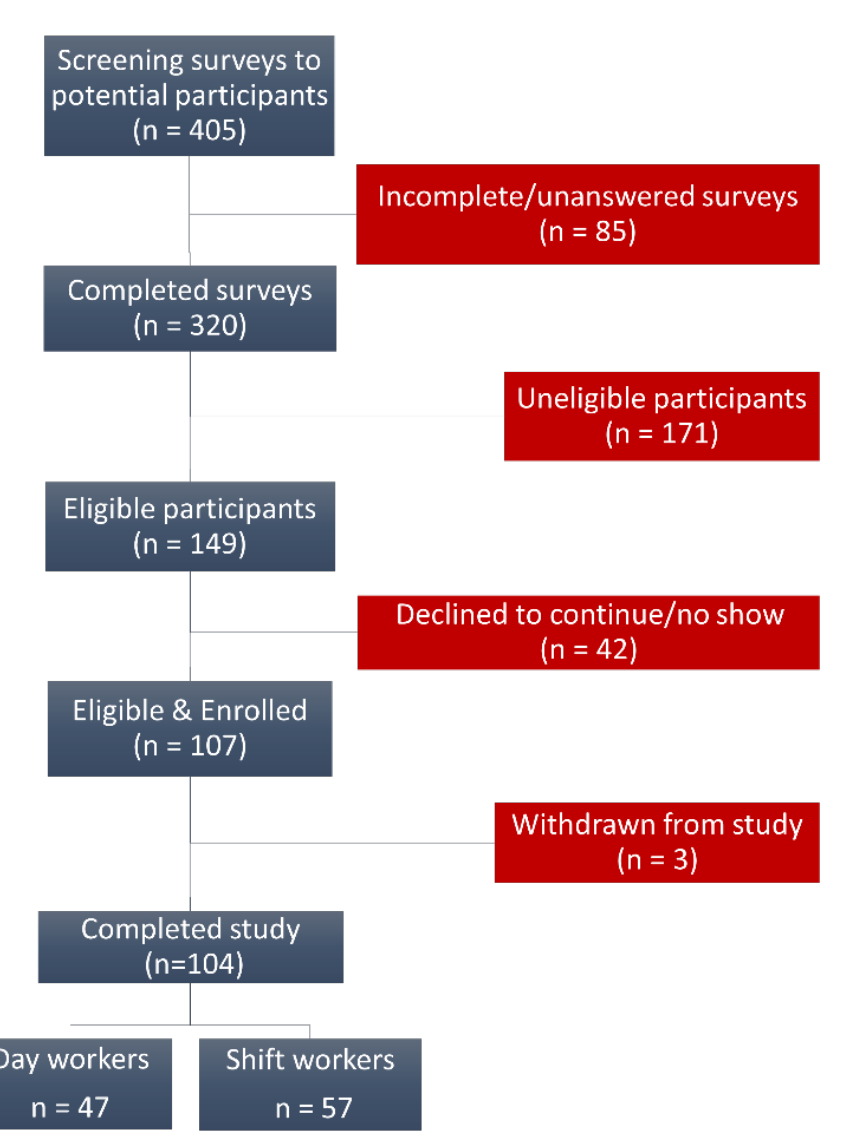
Figure 1. Flow diagram of the recruitment process. Shift workers worked a variety of night schedules that were broadly characterized based on the number of years working night shifts and the number of hours worked per Table 1. Characteristics of the study population. shift. Shift workers had an average exposure to night-shift schedules of 3.97 ± 0.51 years, and in addition, they worked significantly longer hours per shift (mean ± SE = 11.78 ± 0.12 h worked per shift) than day workers did (9.36 ± 0.27 h per shift). Table 1 summarizes the compared characteristics between the day workers and the shift workers and a breakdown of the race/ethnic frequencies by exposure